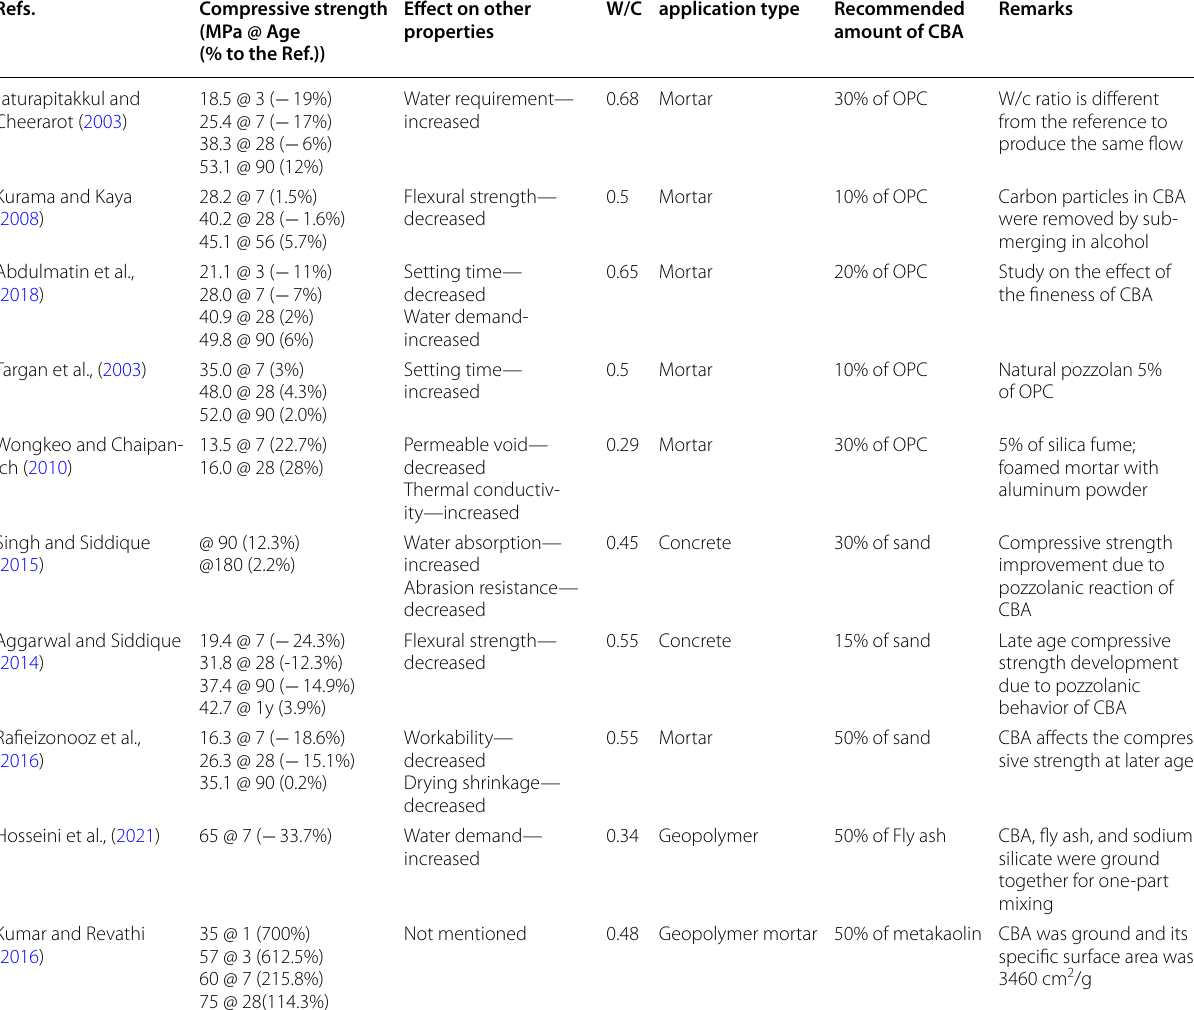
Table 8 Effects of CBA application on compressive strength.